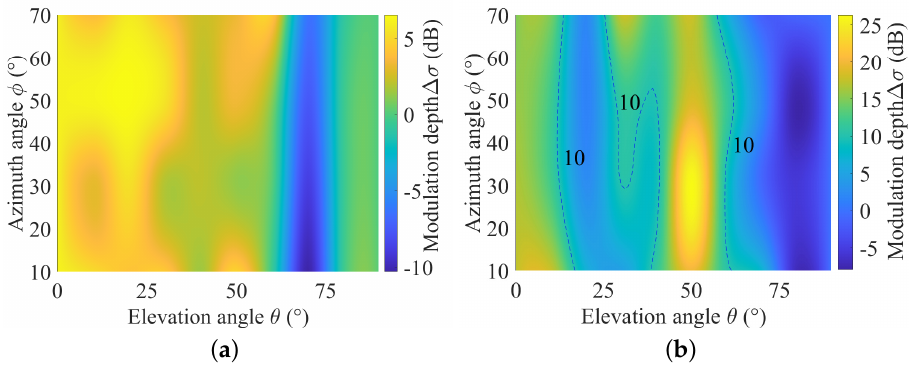
Figure 6. The RCS pattern and modulation depth at 10 GHz and 12 GHz. ( a ) 10 GHz. ( b ) 12